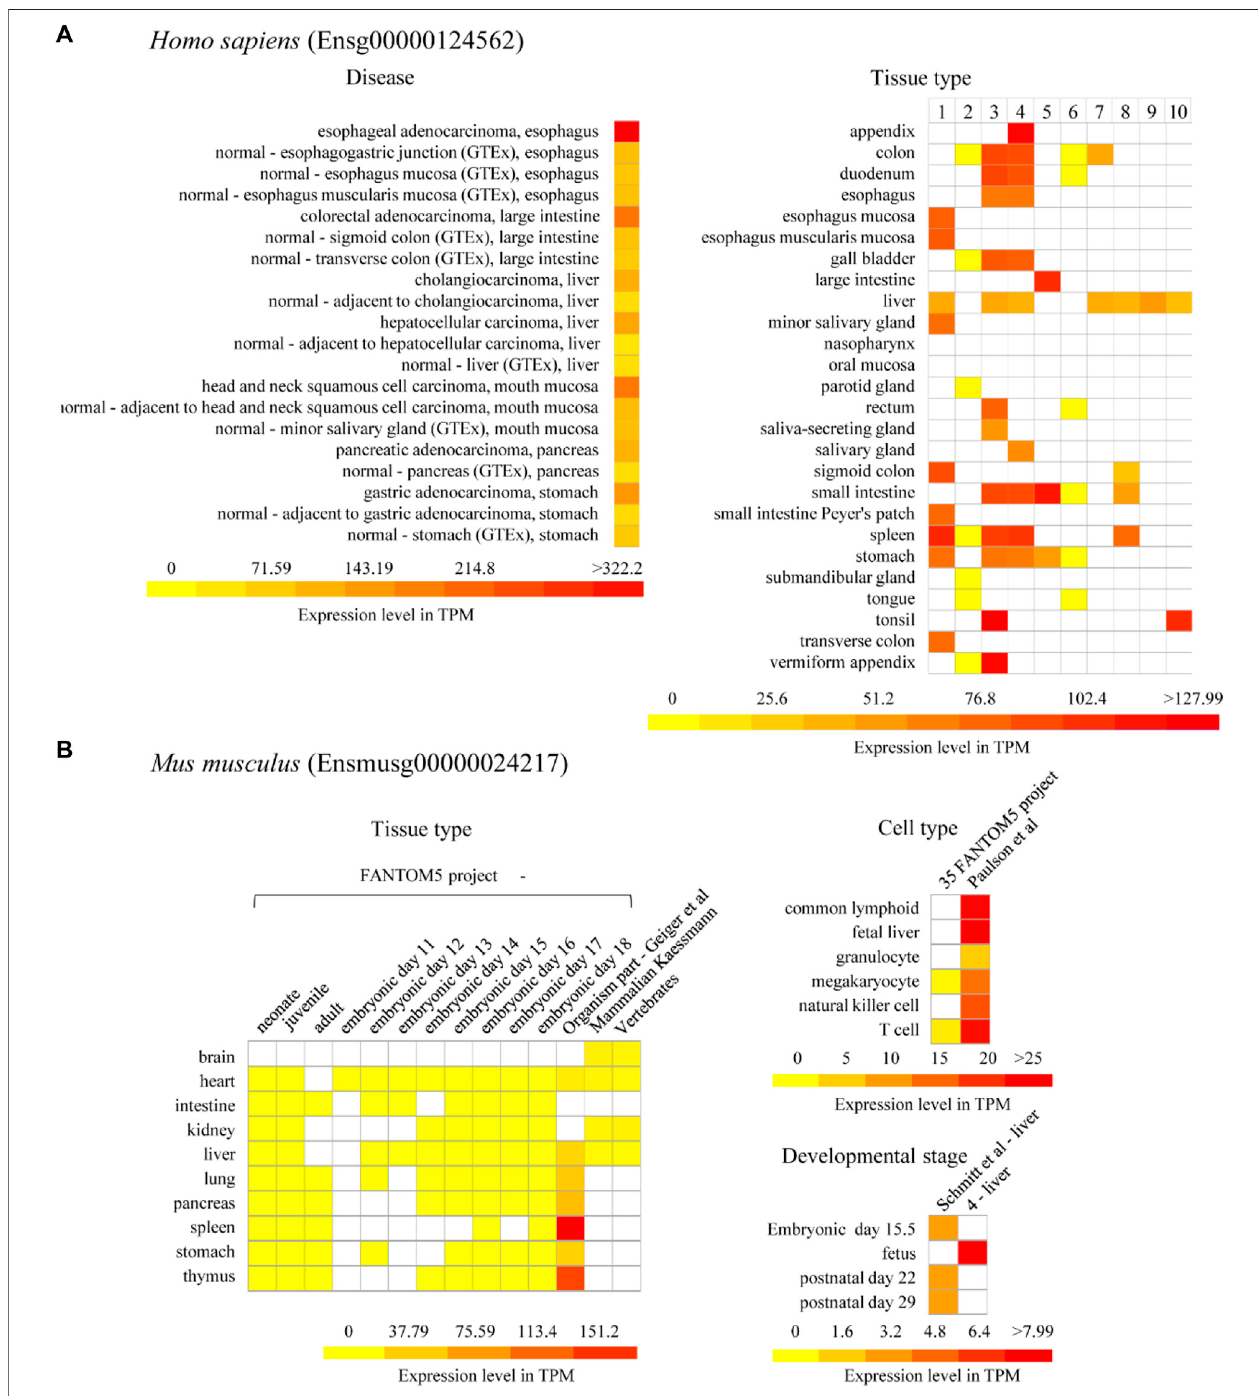
FIGURE 6 | Expression of U1C in model organism Homo sapiens and Mus musculus . (A) Selected representative expression pro fi le of human U1C gene (Ensg00000124562)related tohumandiseasesandorganism partispresented asheatmaps.DiseasedatabaseisfromTheInternationalCancerGenomeproject:Pan- Cancer Analysis of Whole Genomes (PCAWG). GTEx means Genotype-Tissue Expression (GTEx) Project. No.1 – 10 of human-tissue type represents 1) GTEx, 2) FANTOM5 project - adult, 3) Uhlen ’ s Lab, 4) Hallstrom et al., 2014 — Organism part, 5) NIH Epigenomics Roadmap, 6) FANTOM5 project — fetal, 7) Illumina Body Map, 8) ENCODE (M. Snyder lab), 9) Mammalian Kaessmann, 10) Zhu et al., 2018 — Organism part, respectively. (B) Representative expression pro fi les of mouse U1C gene (Ensmusg00000024217) related to tissue type, cell type and developmental stages are shown as heatmaps. The columns in the heatmaps show the available experiments in Expression Atlas. The rows in the heatmaps show experimental condition such as developmental stage, different tissue and cell type and disease condition. White box presents there is no data available. Baseline expression levels are in TPM (transcripts per million). References for each project refer to Supplementary Table S6